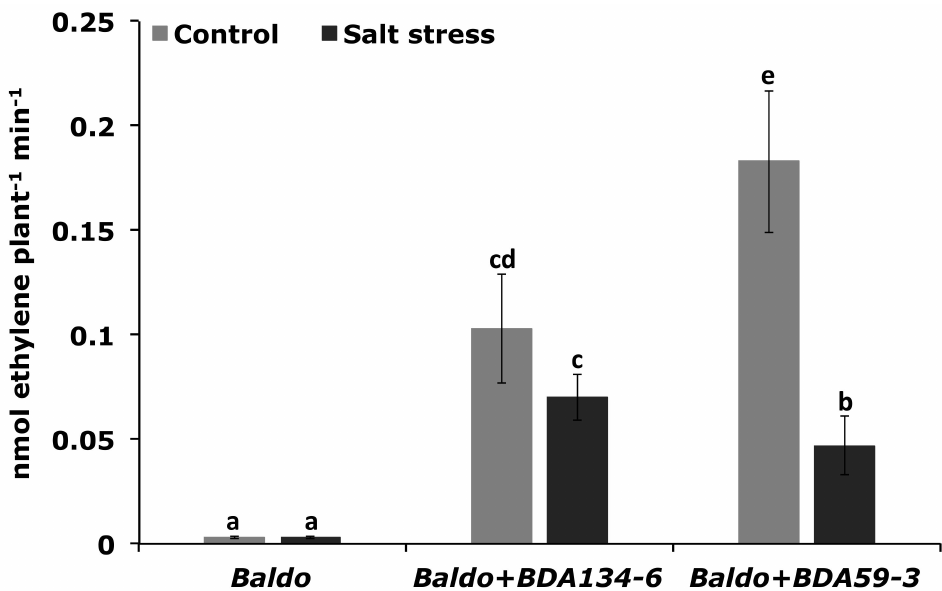
Figure 6. Effect of salinity stress on nitrogenase activity of O. sativa L. cv. Baldo plants inoculated with the endophytes Kl. pasteurii BDA134-6 and P. diazotrophicus BDA59-3. Three-week-old rice plants inoculated with the selected strains were carefully removed from the pots, treated with 0.3 M NaCl for 24 h and used for the ARA test. Data are the means ± SD of at least six independent biological replicates, each carried out at different times. Means with different letters are significantly different at 5% level of confidence (Tukey’s post-hoc